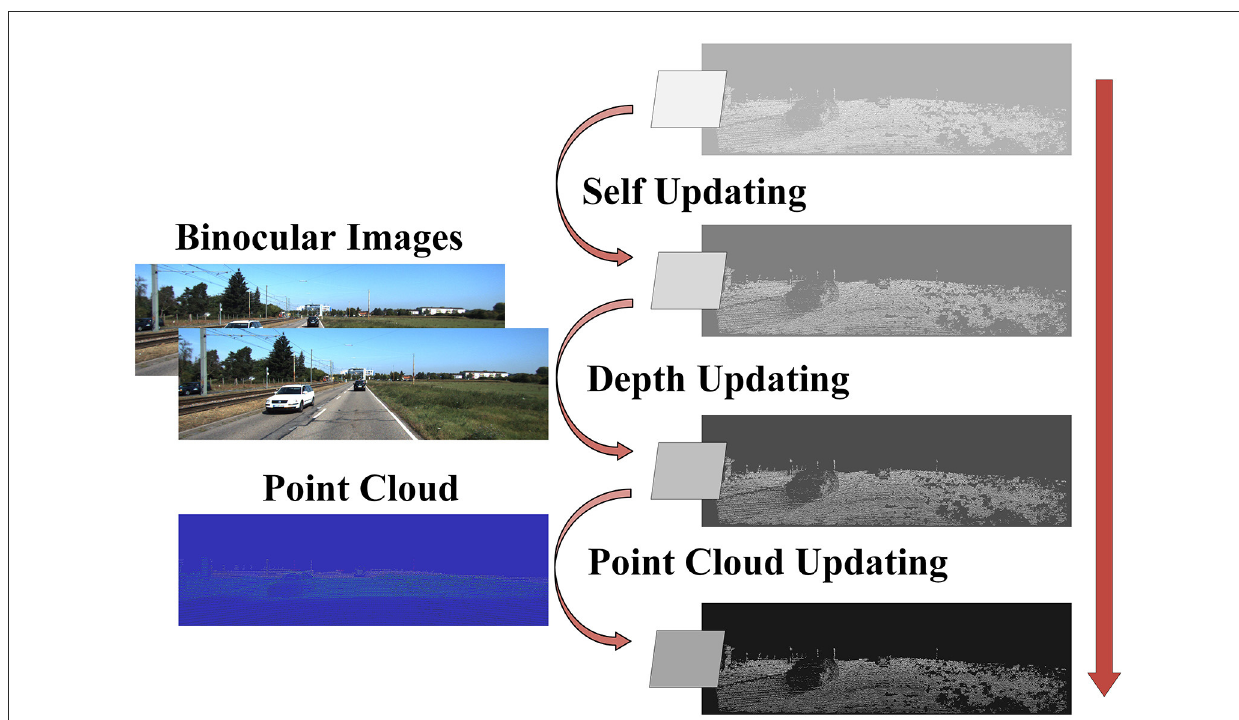
FIGURE3 Schematic diagram of triple updating. Tile hypotheses are the majority of feature representation and update for depth images. The arrow from top to bottom in the direction of the update. The binocular image is injected in the depth updating. The point cloud is incorporated into the point cloud updating.is the model of LiDAR, the lines are